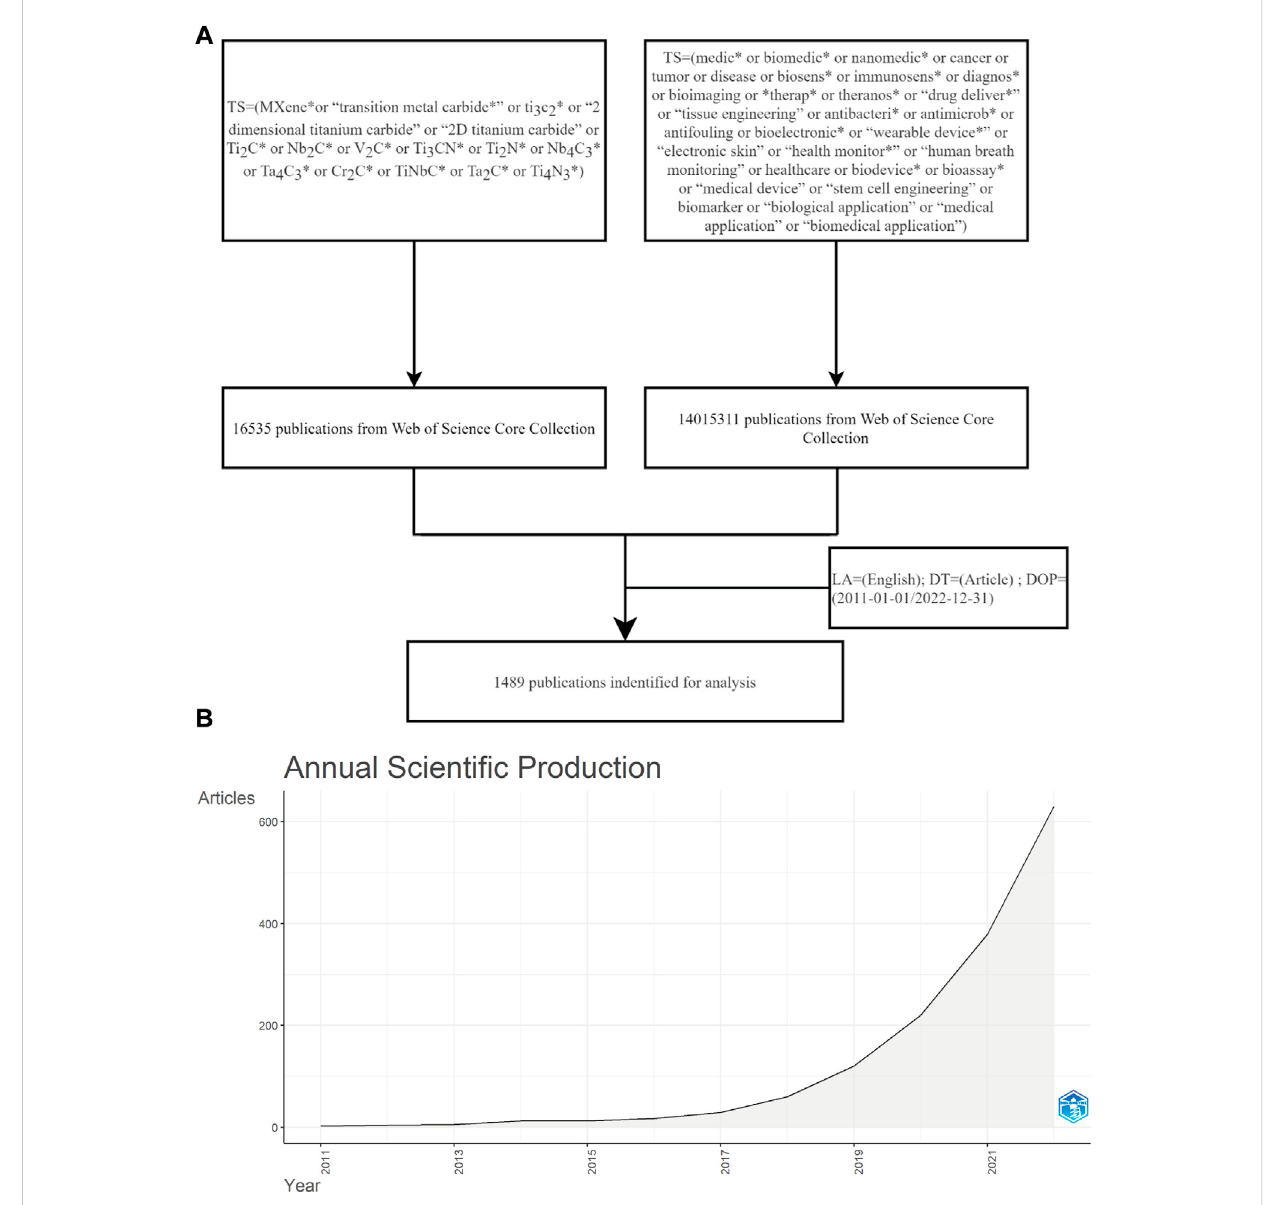
FIGURE 1 Data collection and overall distribution of publication output. (A) Literature screening fl owchart. (B) Annual scienti fi c production